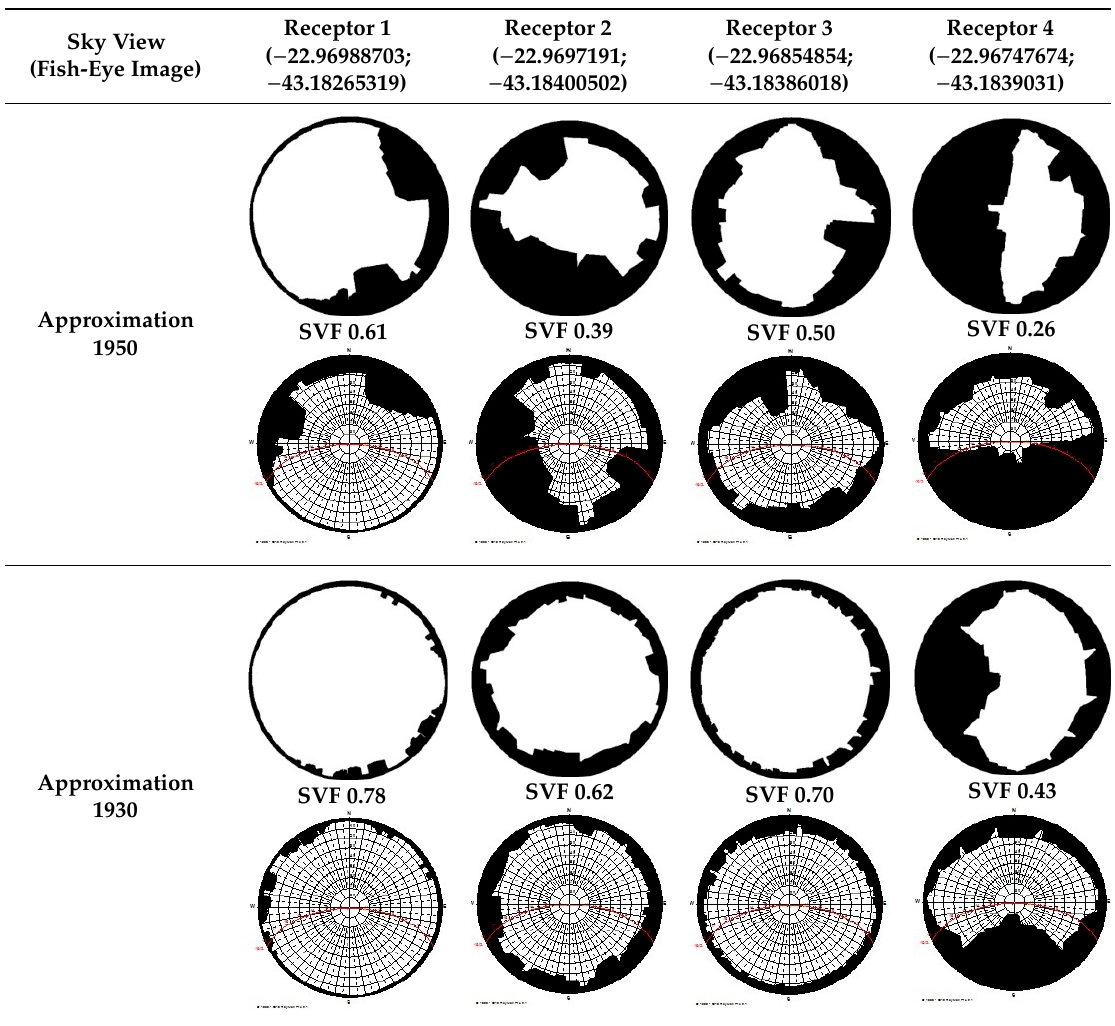
8 of 17 Table 1. Images of the sky taken with a fisheye lens, black and white masks, sky view factor (SVF), and the solar path.